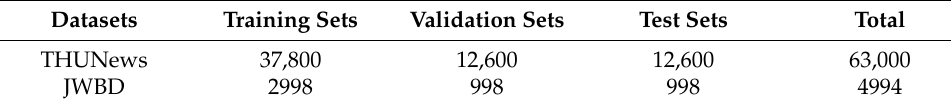
Table 1. Experimental dataset.